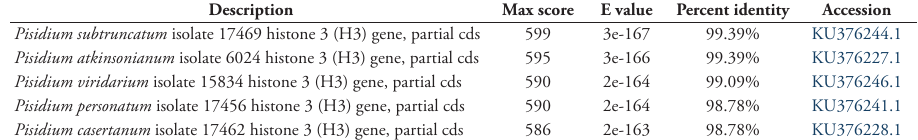
table 3. List of the first five significant BLAST hits (NCBI GenBank accessed on 15/06/2019).